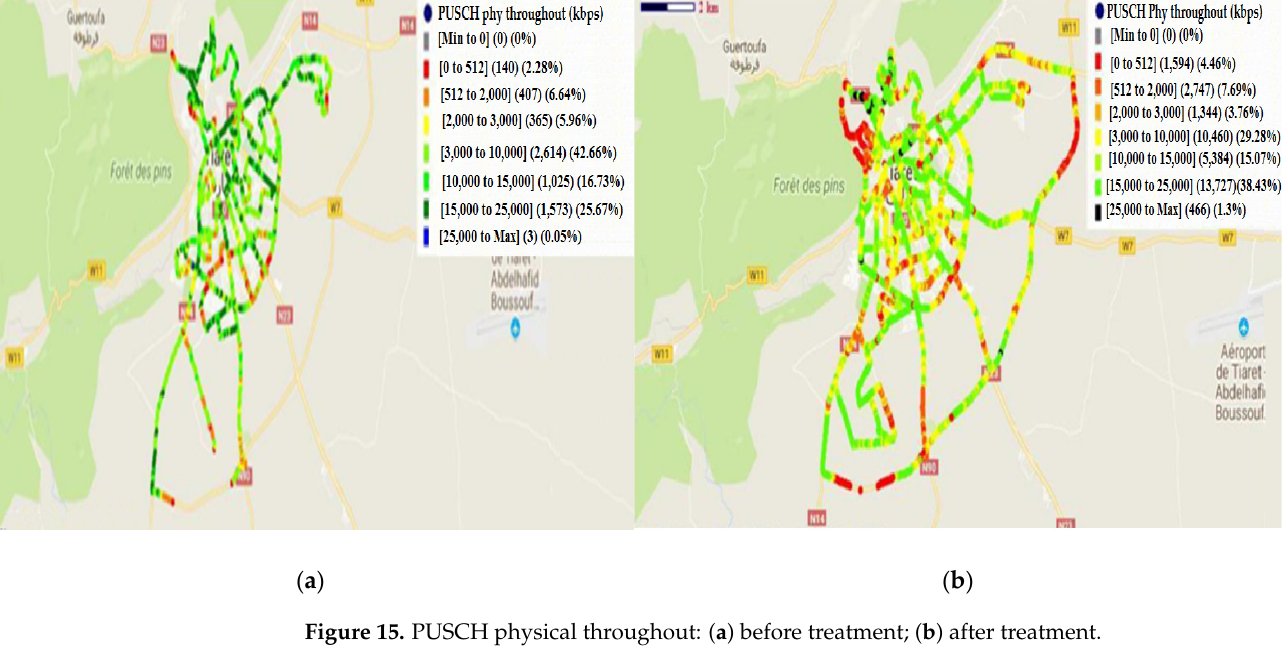
Table 5. PUSCH physical values before and after treatment. Range (Mbps)